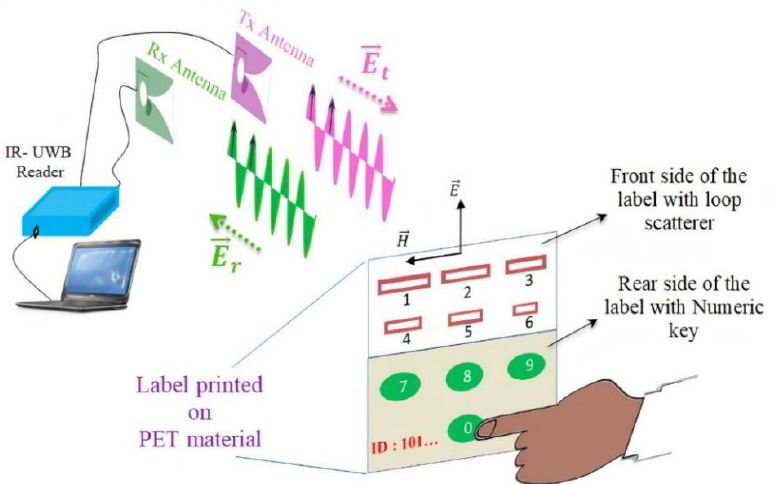
Figure 1. System architecture of wireless numeric keypad based on Chipless RFID.